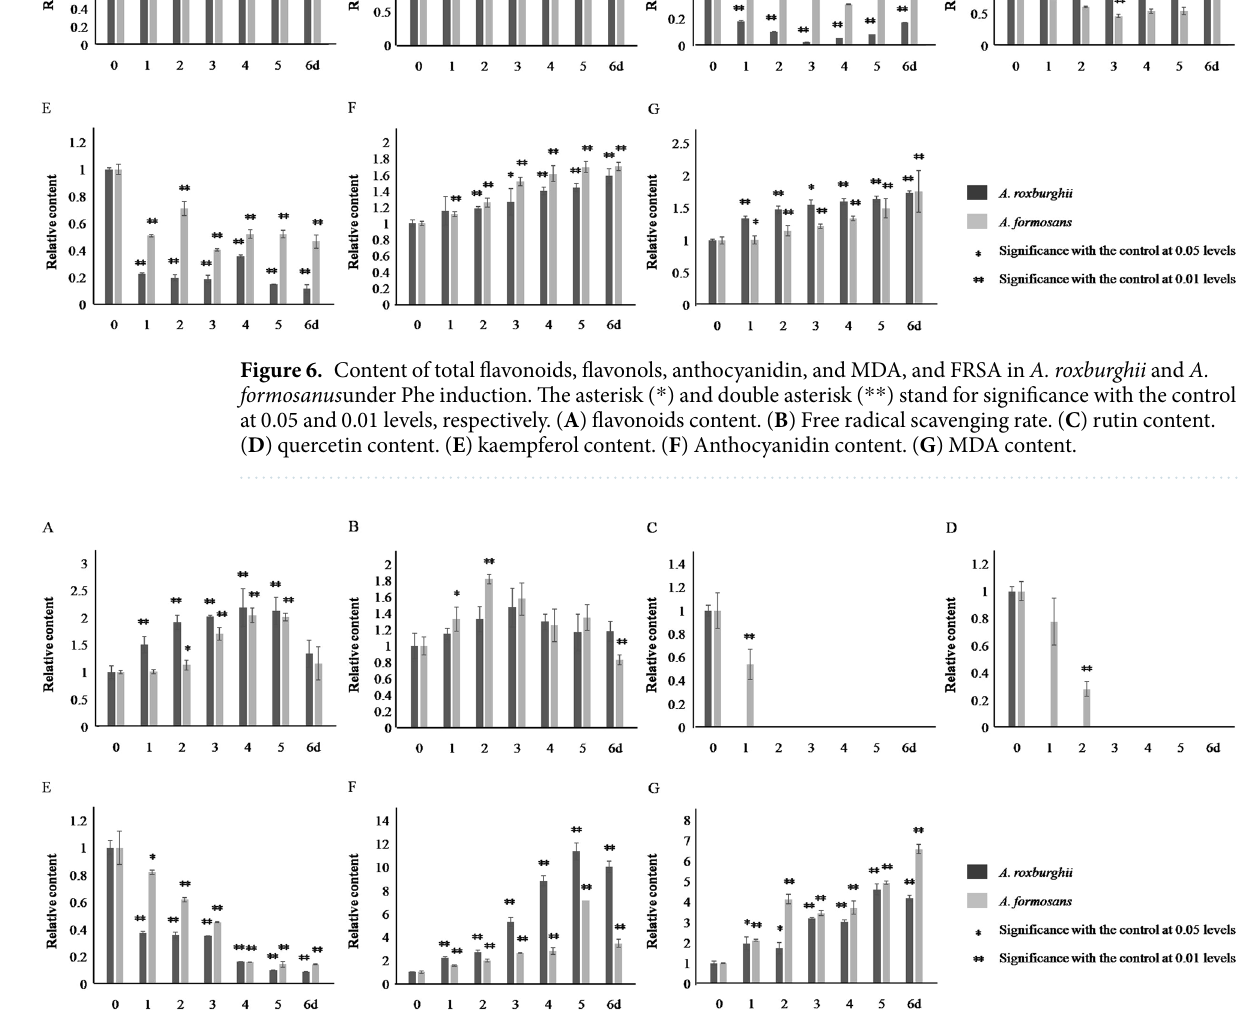
Figure 7. Content of total flavonoids, flavonol, anthocyanidin, and MDA, and FRSA in A. roxburghii and A. formosanus under UV induction. The asterisk ( * ) and double asterisk ( ** ) stand for significance with the control at 0.05 and 0.01 levels, respectively. ( A ) flavonoids content. ( B ) Free radical scavenging rate. ( C ) rutin content. ( D ) quercetin content. ( E ) kaempferol content. ( F ) Anthocyanidin content. ( G ) MDA